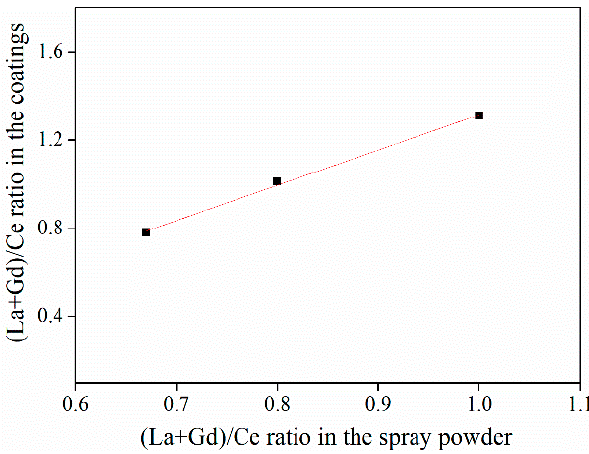
Figure 2. The relationship of the (La + Gd)/Ce ratio between the spray powders and coatings.